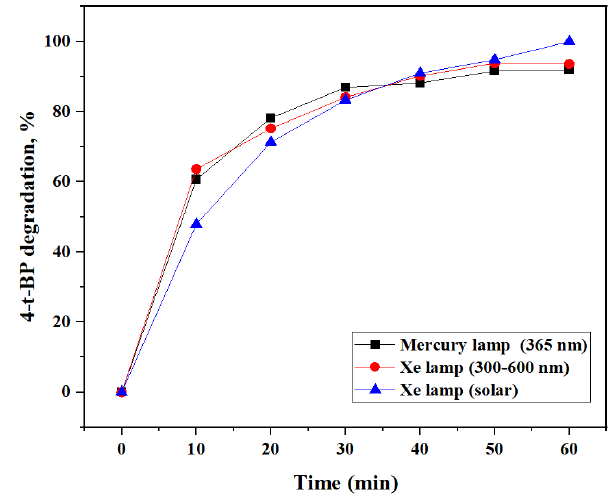
Figure 6. Effect of lamp types on the degradation of 4-t-BP. Experimental conditions: [4-t-BP] 0 = 5 ppm, catalyst dosage = 200 mg/L. Table 3. EE O estimated for different type of lamps.